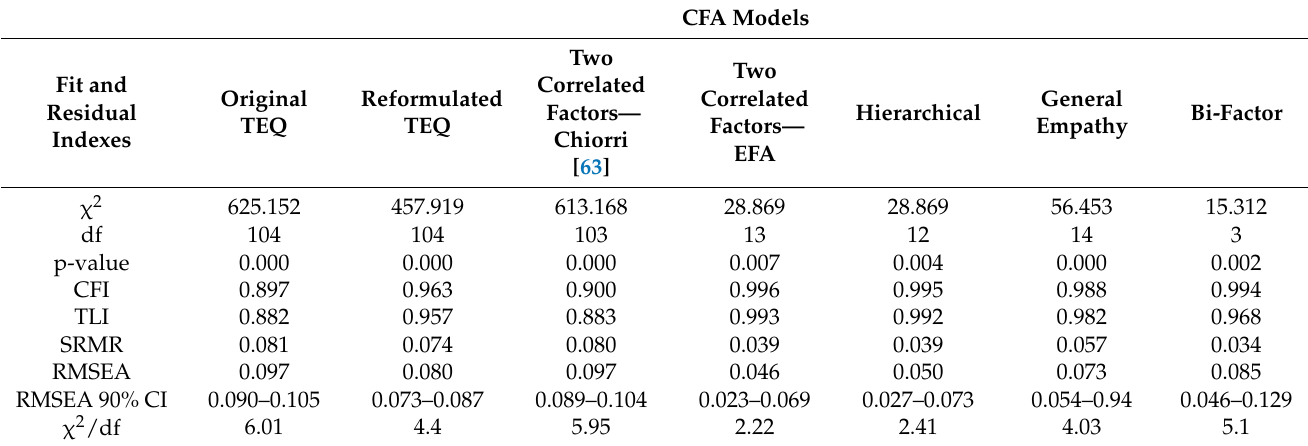
Table 2. Model fit and residual indexes of CFA models (Study 1, n = 1141).